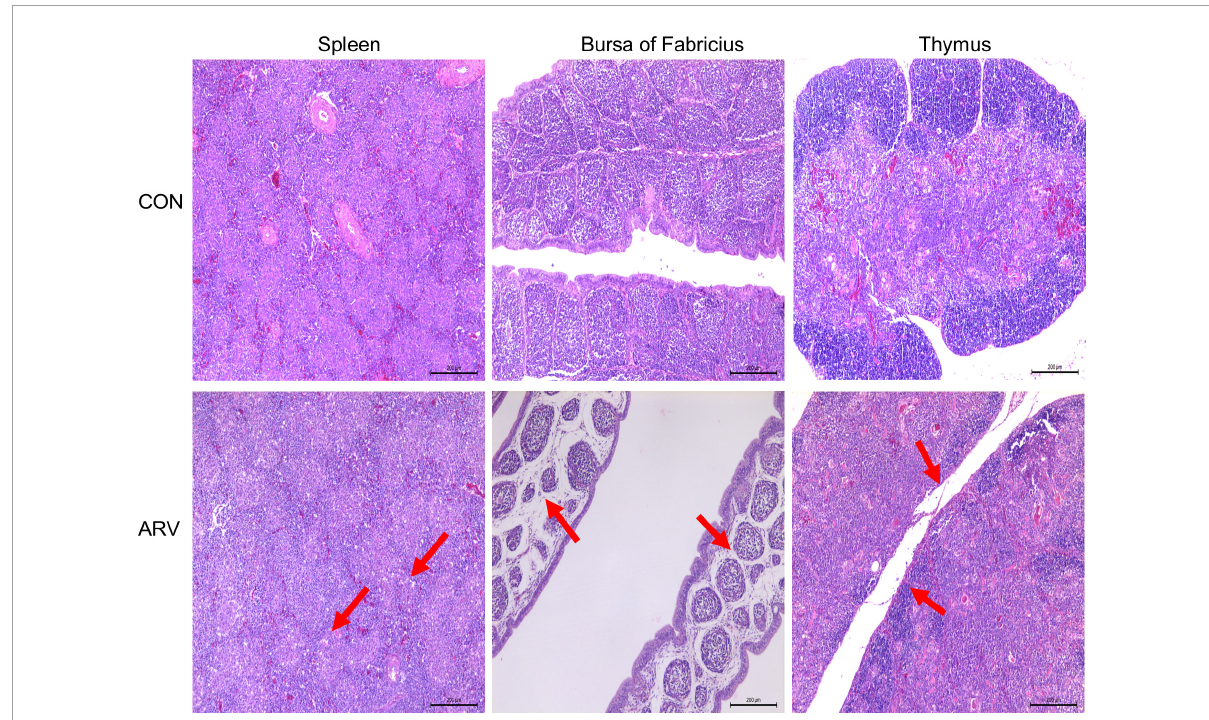
FIGURE2 Histopathological changes in the spleen, bursa of Fabricius, and thymus in SPF chickens infected with ARV. In the control group (CON), SPF chickens were injected with 0.1 ml of PBS into the footpad. In the experimental group (ARV), ARV strain S1133 (10 4 TCID 50 /0.1 ml) was injected into SPF chickens through the footpad. The arrow in the spleen indicates extensive lymphocyte degeneration and necrosis. Arrows in the bursa of Fabricius indicate lymphatic follicular structural loosening, lymphocytic degeneration and necrosis, heterophilic cell infiltration, interstitial loosening, and inflammatory cell infiltration. Arrows in the thymus indicate atrophy, reduced cortex/medulla proportions, and decreased cortical lymphocytes.